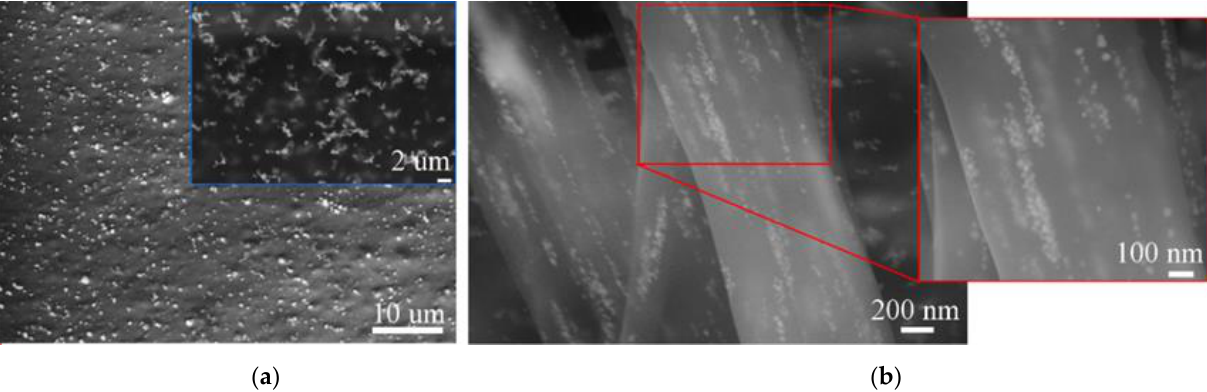
Figure 6. SEM images of ex situ PVA-20AgNPs (increased amount of nanoparticles) thin layers with detailed view on AgNPs ( a ); fibers with detailed view of the AgNPs distribution ( b ).